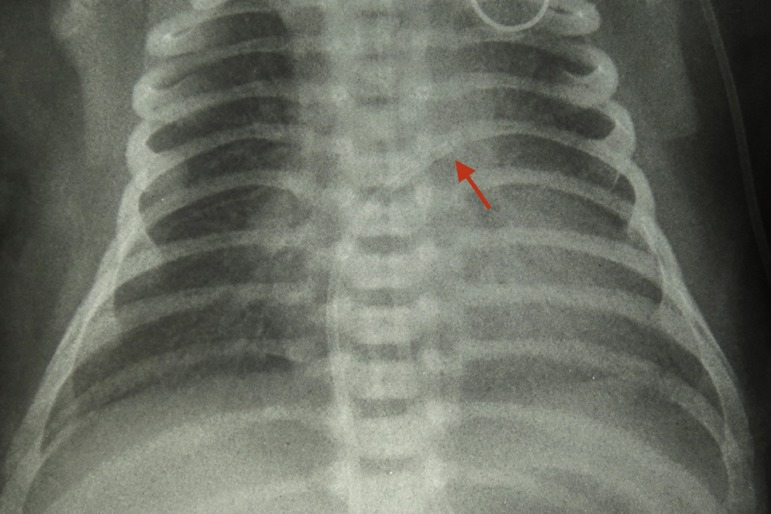
Cateter umbilical venoso intracardíaco em topografia de átrio esquerdo.